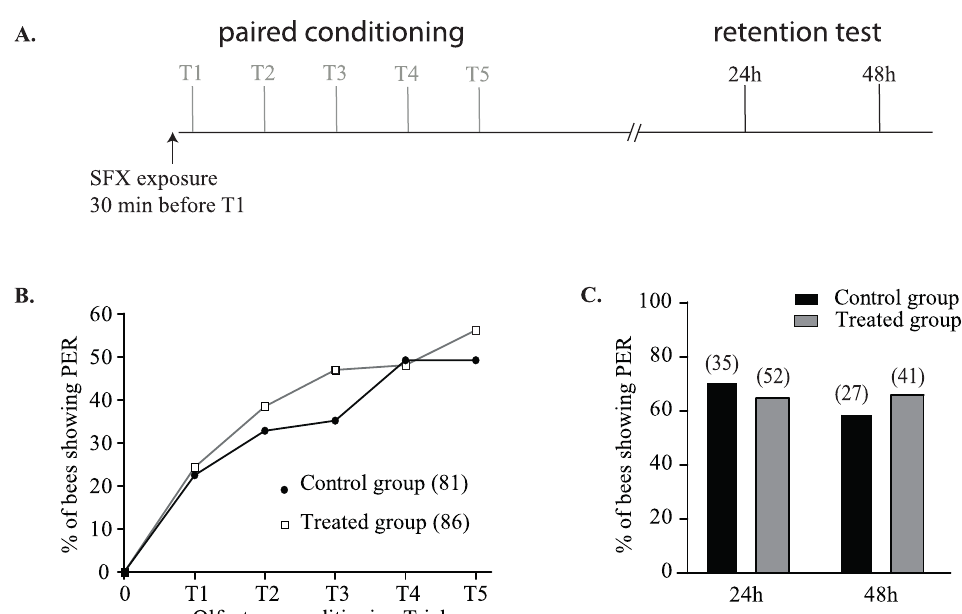
Fig 3. Effect of sulfoxafor sublethal dose on learning ability and memory formation after 30 minutes exposure before conditioning. A . Experimental procedure used: 30 min before the first olfactory conditioning trial (T1), treated and control bees received 2 μ L of SFX solution (15 ng/bee) or 50% (w/v) sucrose solution respectively. B . The response (PER or no PER) of each bee was registered during each conditioning trial. Only surviving bees showing a proboscis extension response at the end of the olfactory conditioning were considered for the restitution test. C . The restitution tests were performed 24 h and 48 h after the last olfactory conditioning trial. No significant difference was observed between the treated and control groups (P > 0.05). The number of individuals in each group is given in the brackets.